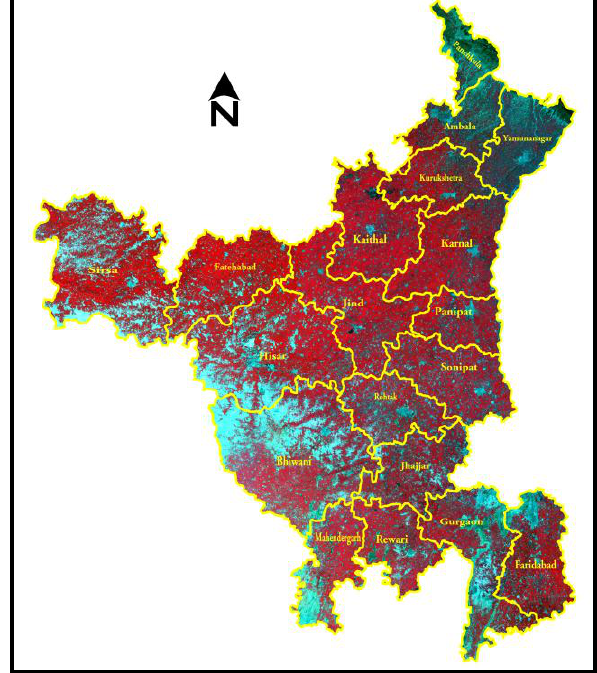
Figure 2. Haryana state as viewed by